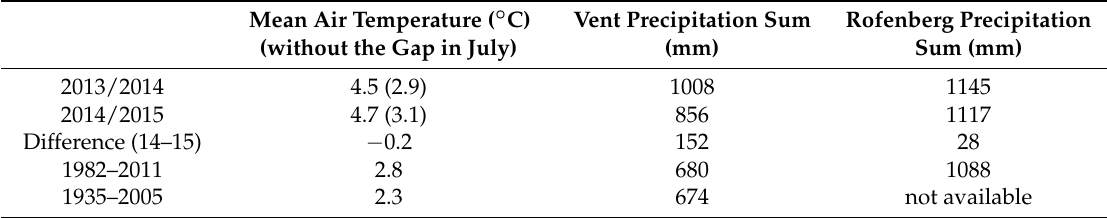
Table 1. Mean air temperature and precipitation sums at the weather station at Vent (1898 m a.s.l.) [47,48] and precipitation sums from a rain gauge at Rofenberg (2827 m a.s.l.).